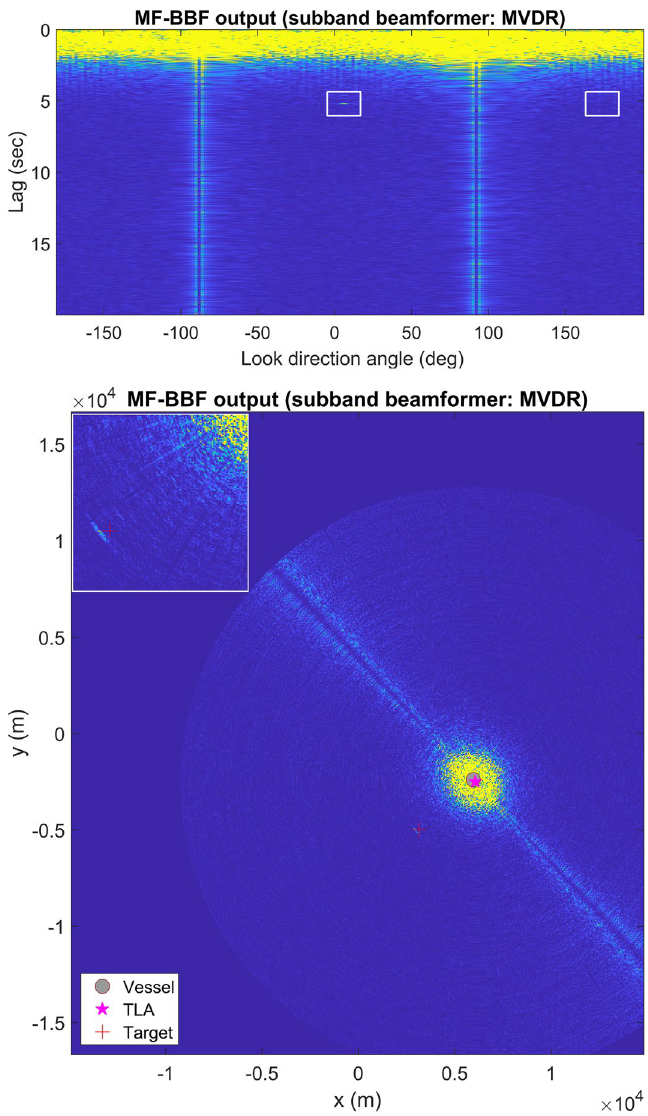
Fig. 9 Processing outputs obtained for SST data; the subband beamformer used: MVDR. The upper left corner of the lower display shows an image obtained by zooming in on the target